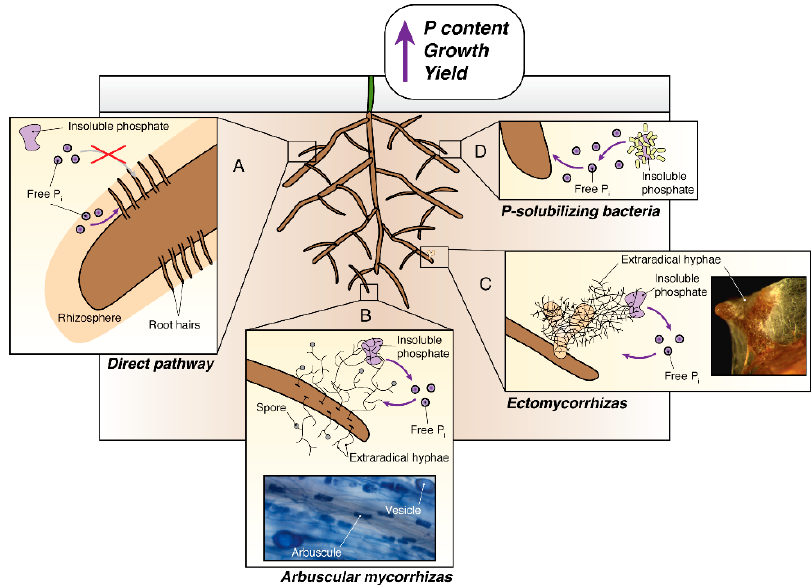
Figure 1. Schematic model showing the acquisition of phosphorus in plants, facilitated by arbuscular mycorrhizal fungi, ectomycorrhizal fungi, and P-solubilizing bacteria. ( A ) Root hairs on the roots of plants are able to acquire inorganic phosphate (P i ) from soil that is within close proximity (e.g., within the rhizosphere). This method of P i acquisition is known as the direct uptake pathway. Insoluble forms of phosphate and free P i that are outside of the rhizosphere cannot be reached by the plant (red cross). ( B ) Spores of arbuscular mycorrhizal fungi germinate, and emerging hyphae make contact with and penetrate roots in order to form arbuscules and sometimes vesicles in plant cortical cells. Extraradical hyphae exploring the soil can extract P i from insoluble forms of phosphate (e.g., minerals and organic matter) and acquire it. P i is then transported through the hyphae colonizing the roots and delivered to plant cells. ( C ) Specific plant–fungal structures called ectomycorrhizas can be formed on woody plant roots. As with arbuscular mycorrhizas, extraradical hyphae exploring the soil extract P i from insoluble forms and acquire it. These hyphae can sometimes form rhizomorphs that are highly differentiated structures (not represented here). P i is transported towards the roots and then delivered to plant cells. ( D ) Insoluble forms of phosphate are actively degraded by P-solubilizing bacteria. The resulting free P i can either be taken up by the roots or other organisms, including mycorrhizal fungi. The improvement of P acquisition through direct or indirect microbial pathways leads to the increase of P content in aboveground tissues (e.g., seeds and fruits), thus increasing plant growth and yield.